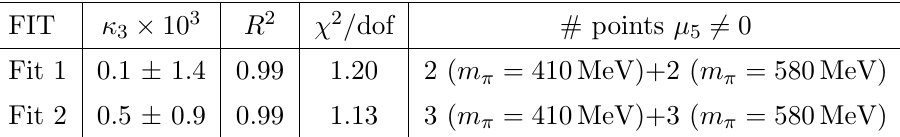
Table 3 . Numerical values of the parameters corresponding to the (cid:12)ts in (cid:12)gure 7. The last column indicates the number of lower (cid:22) 5 points considered. error bands corresponding to the 95% con(cid:12)dence level of the (cid:12)ts are much narrower than the natural values showed in (cid:12)gure